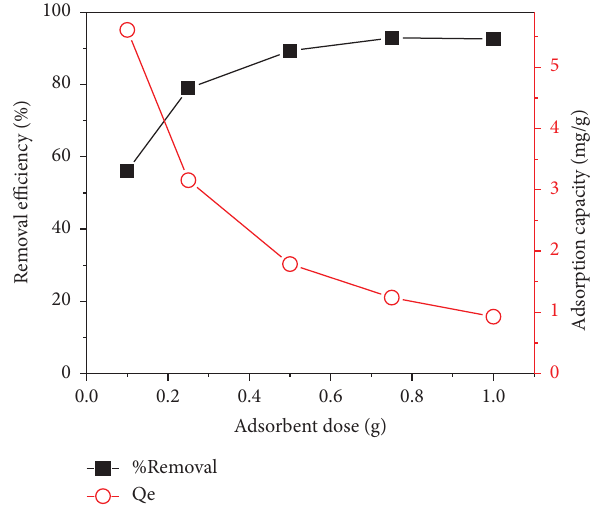
Figure 8: Efect of adsorbent dose on removal efciency and equilibrium adsorption capacity (pH � 7, 30min contact time, 10mg/L starting fuoride ion concentration at 25 ° C).